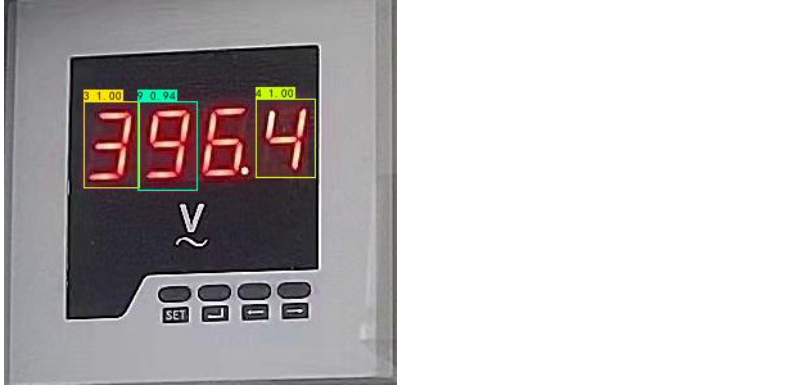
Figure 12. Schematic diagram of missed detection of number